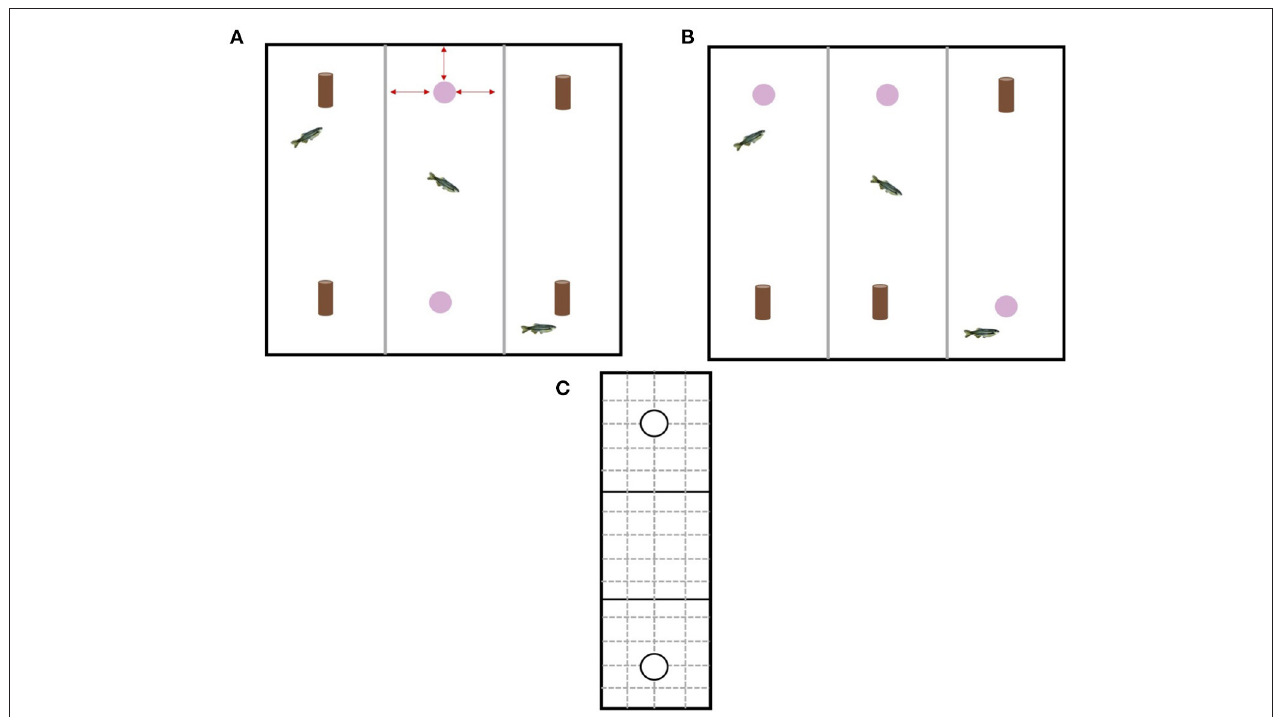
FIGURE 3 | (A) Design of the experimental tank during the acquisition phase. The experimental tank had three different chambers for individual testing of fish. Gray opaque plastic dividers separated each chamber. During the acquisition phase each fish received two copies of the same object, however, which type of object (pink bead or brown bead) was alternated to provide equal numbers of fish within each treatment that had been exposed to the different objects. Red arrows indicate the object was equidistant from the three walls surrounding it (B) Design of the experimental tank during the retention phase. During the retention phase each fish received one copy of the original (familiar) object and one copy of the new (novel) object. The location of the object was rotated to minimize any effects of side bias. (C) Schematic of the acetate used to analyze the behavioral videos. Solid black lines depict the three different zones (object 1 zone, neutral middle zone, object 2 zone) and solid black circles depict the encounter zone around each object. Solid black lines and dashed gray lines indicate lines used for quantifying movement